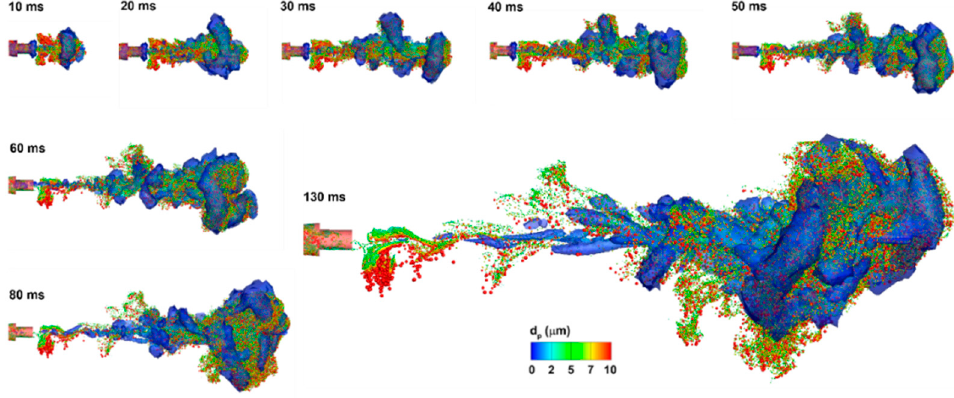
Figure 6. MDI vortex and aerosol dynamics at varying instants after being discharged.